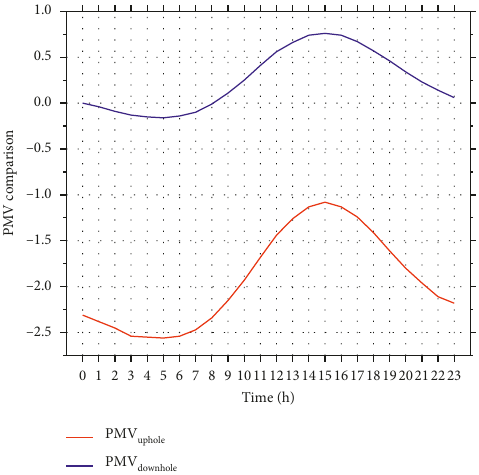
Figure 6: Thermal comfort curves in the uphole and downhole environments. Note: PMV uphole_pre refers to the predicted thermal comfort values in the well; PMV downhole_mod refers to the modified downhole thermal comfort values; and PMV refers to the difference between the conditions in the well and the downhole thermal comfort.